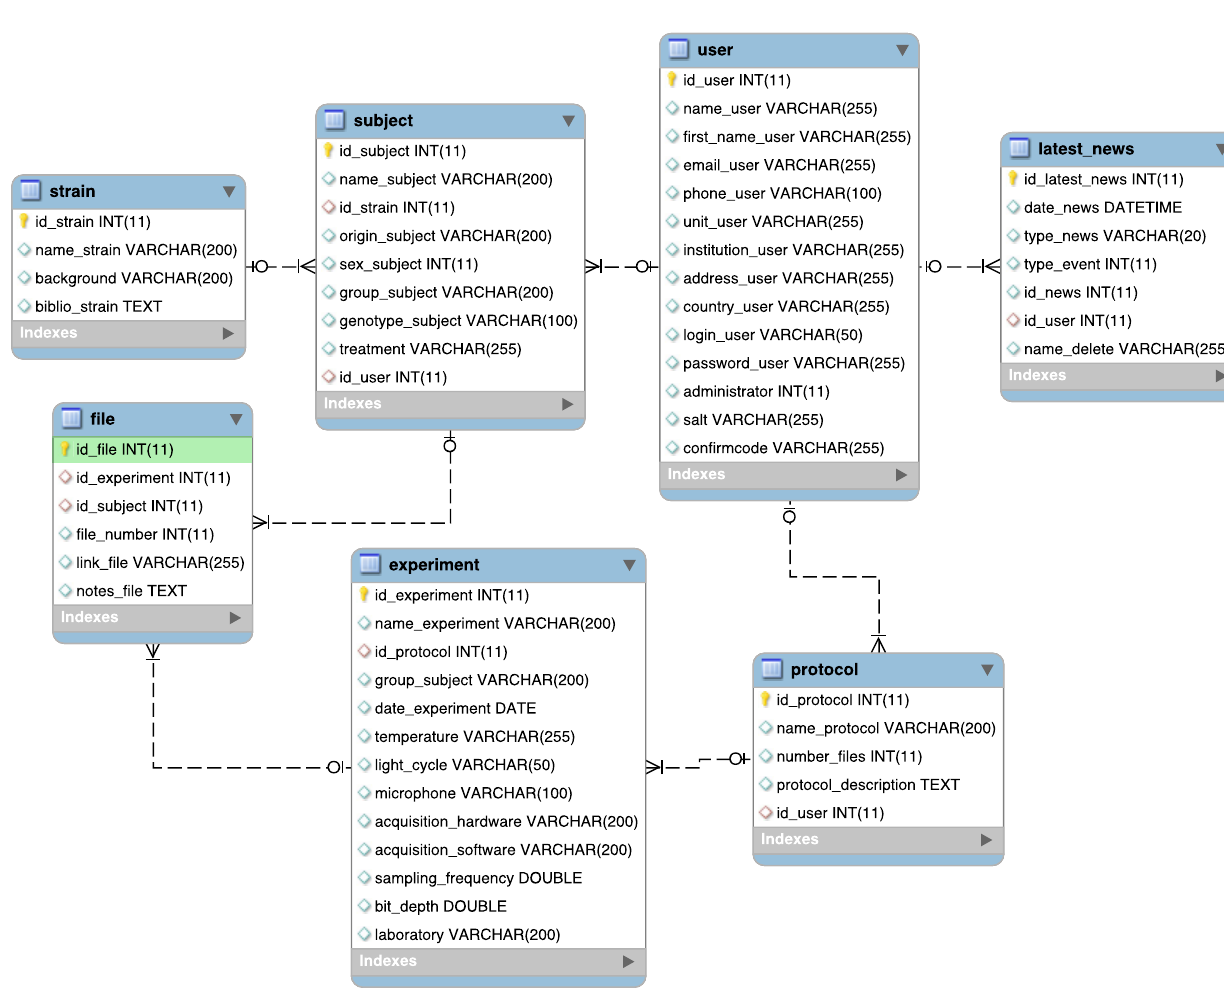
Figure 1. Overall organisation of the mouseTube database. mouseTube is organised in 7 tables connected by unique